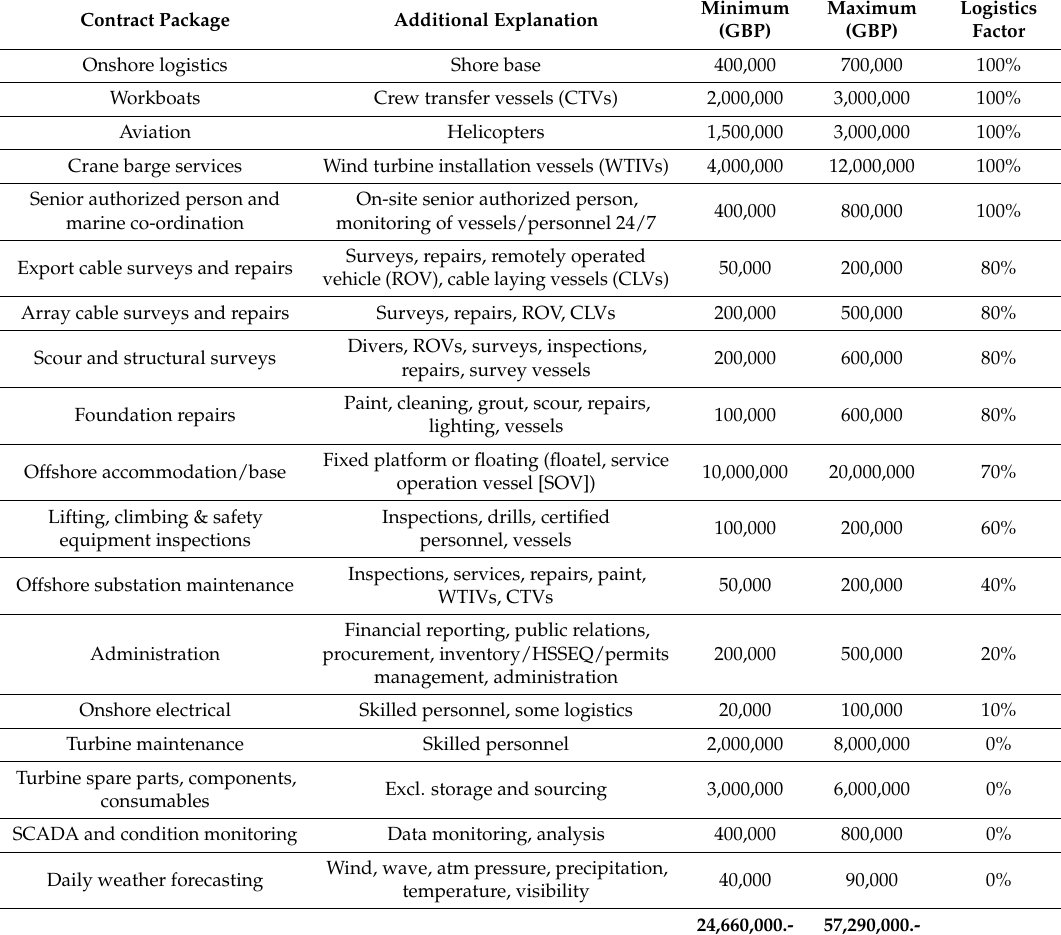
Table 5. Cost line items in the logistics base case study (table developed based on [68]).